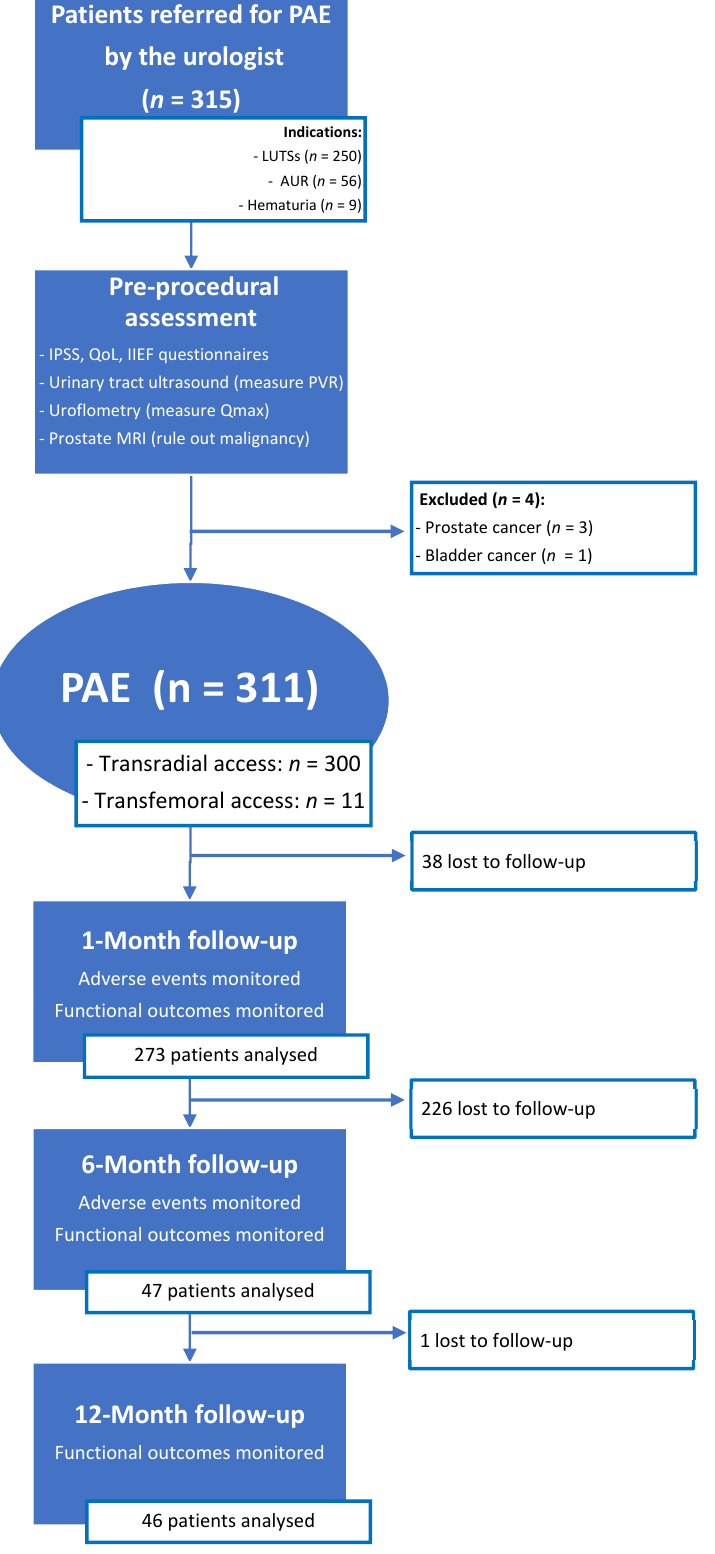
Figure 2. Patient flowchart. PAE: prostatic artery embolization; LUTSs: lower urinary tract symptoms; AUR: acute urinary retention; IPSS: international prostatic symptoms score; QoL: quality of life; IIEF: international index of erectile function; PVR: post-voiding residue; Qmax: maximum urinary